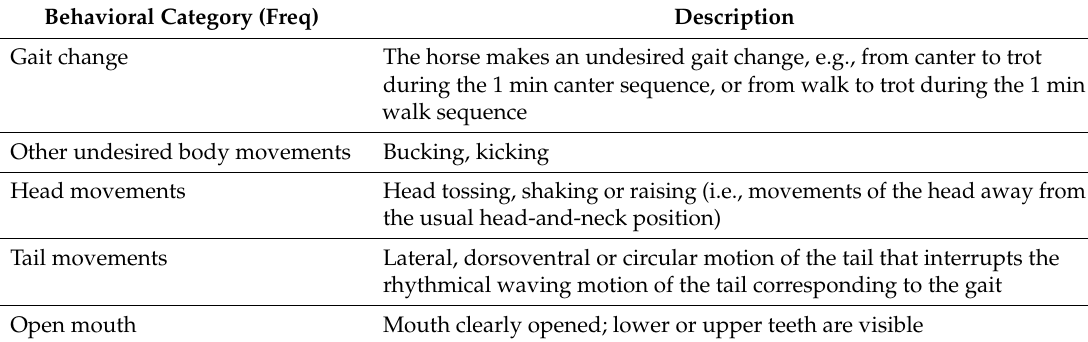
Table 3. Ethogram of recorded